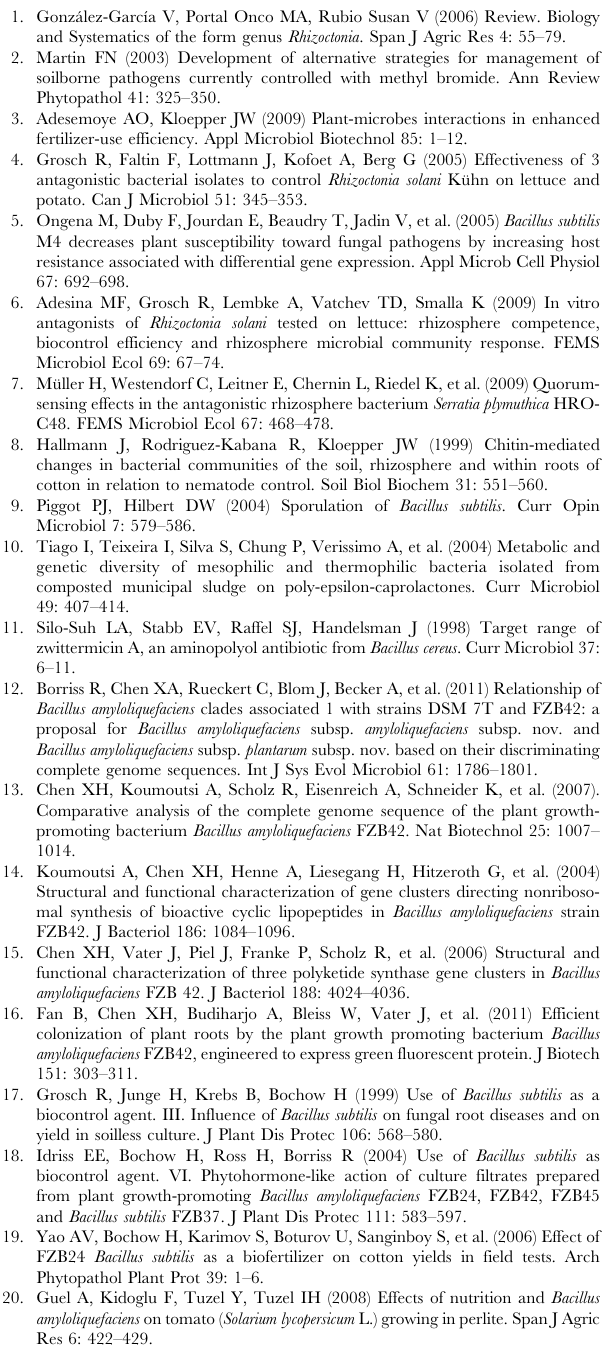
Table S1 R test statistic